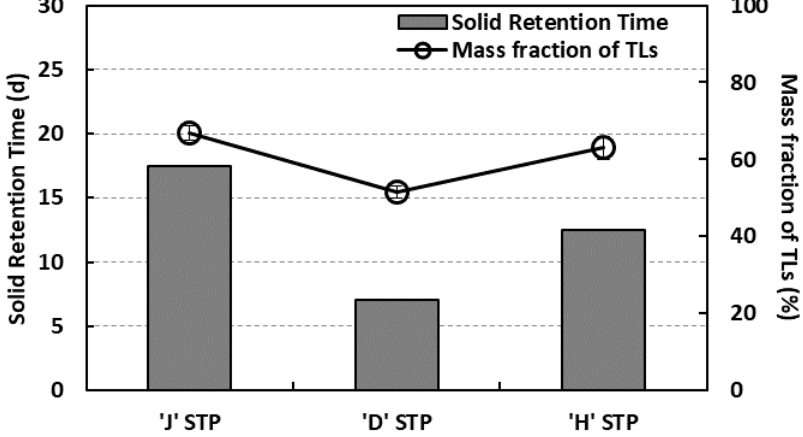
Figure 2. Relationship between transesterifiable lipid (TL) fraction from WAS and solid retention time (SRT).